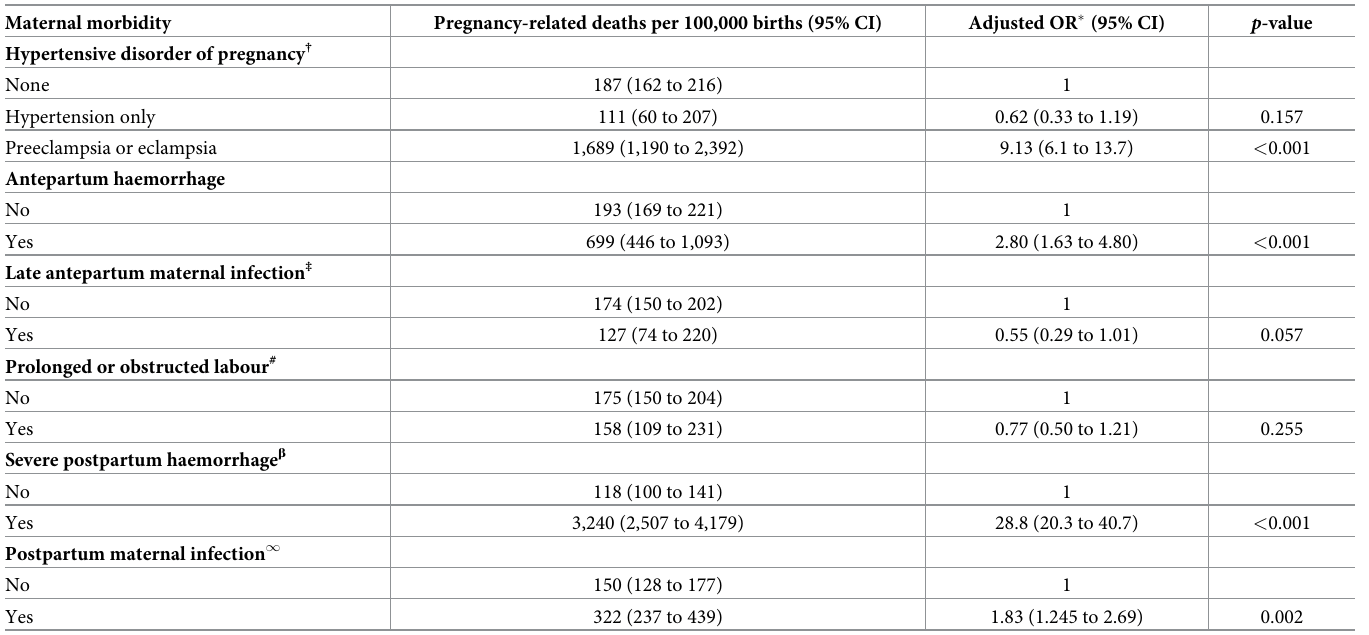
Table 3. Association of maternal morbidities with pregnancy-related deaths.